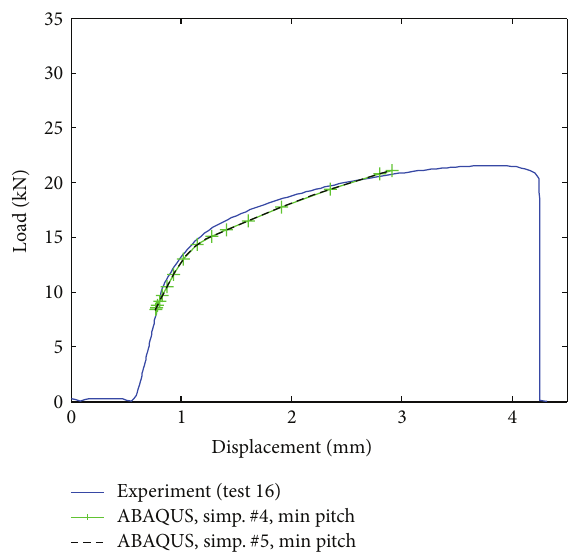
Figure 11: Force-displacement results for static tension test, simpli- fied model #4-5.